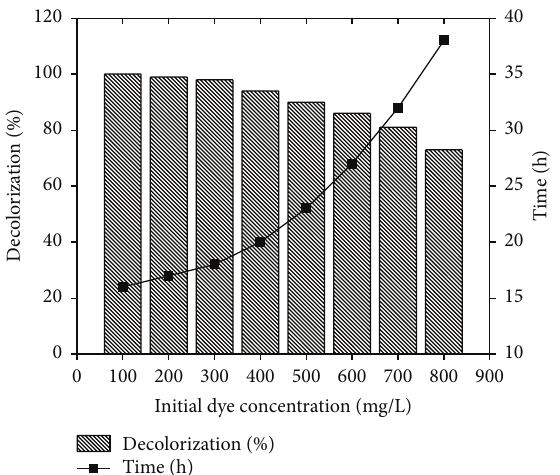
Figure 7: Effect of salt concentration on decolorization of Reactive Violet 5.